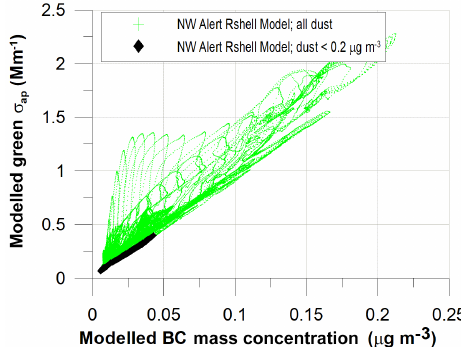
Figure 6. Modelled light absorption coefficients ( σ ap ) at 550nm plotted against black carbon (BC) mass concentrations for the NW Alert grid and the Rshell assumption (green). The black diamonds indicate the data limited to those points with dust concentrations less than 0.2µgm − 3